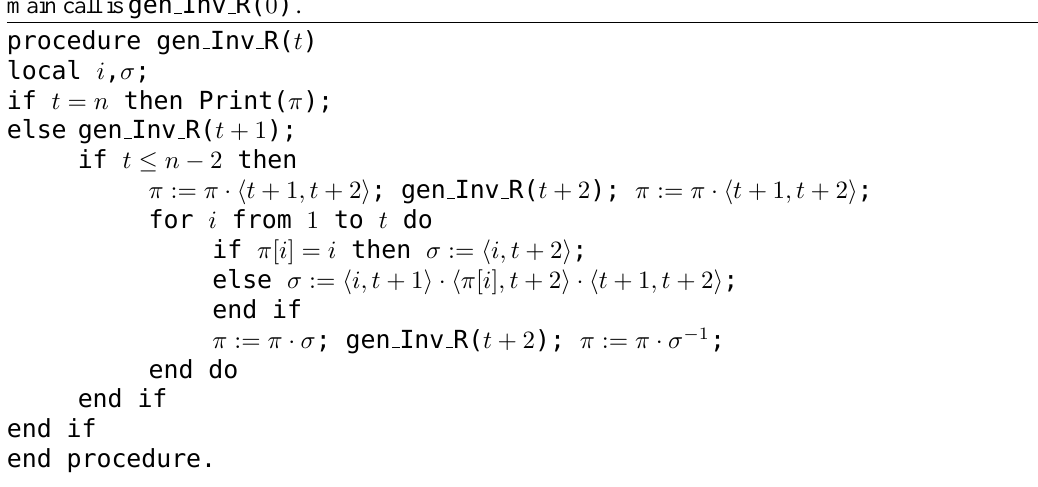
Algorithm 4 Procedure generating length- n involutions by recurrence. Initially π = 1 2 3 . . . n and the main call is gen Inv R( 0 )